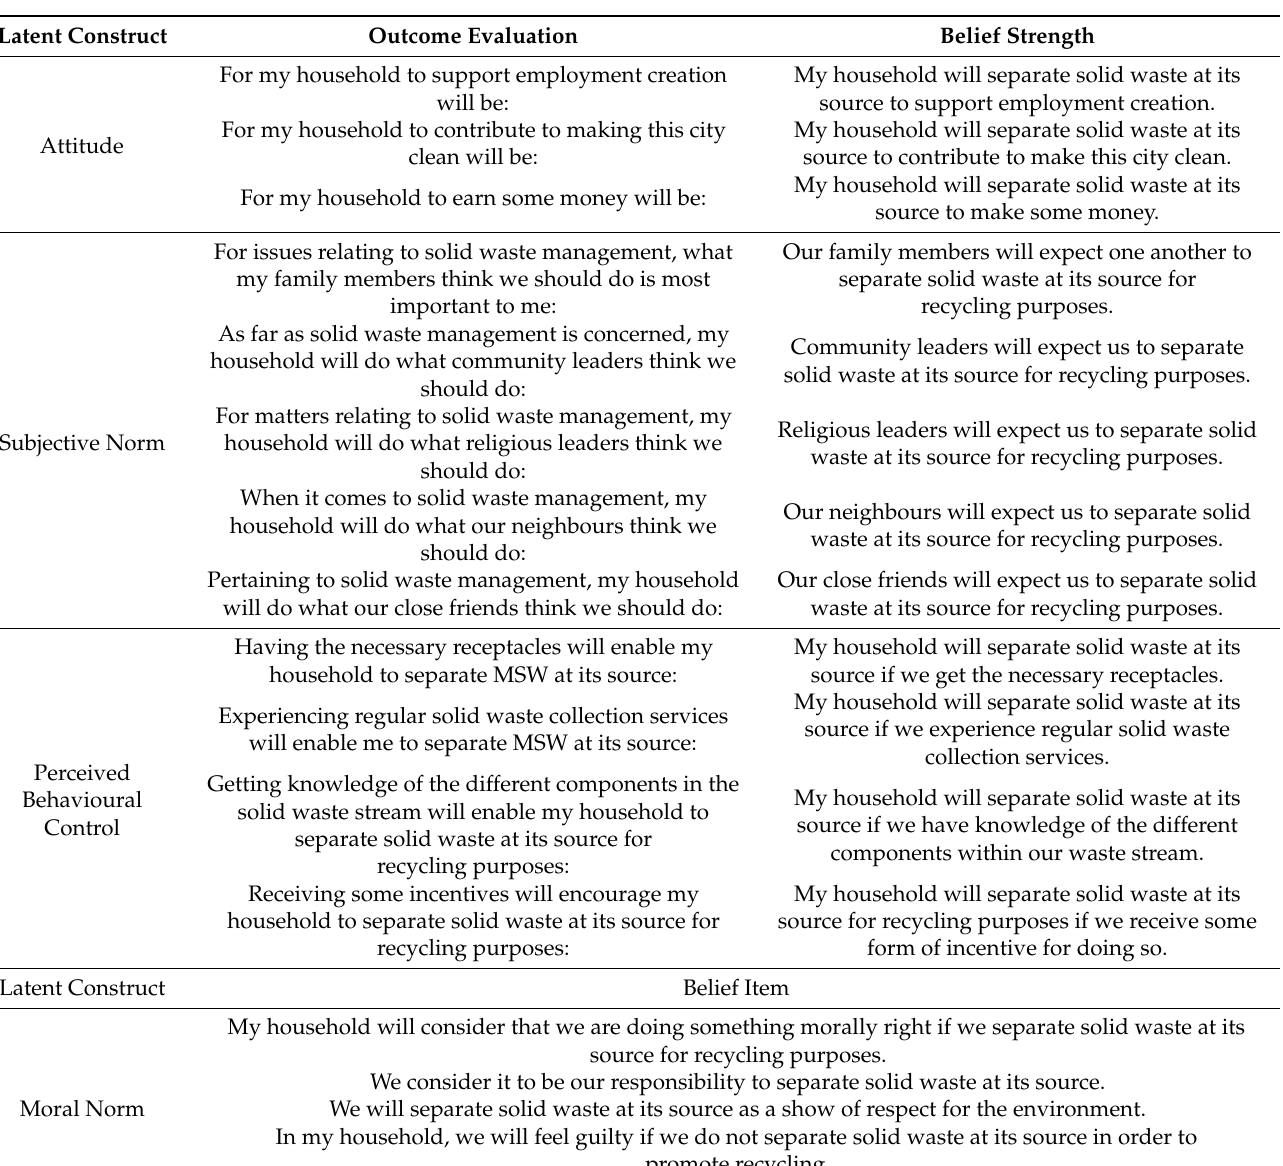
Table 1. Questionnaire items related to the